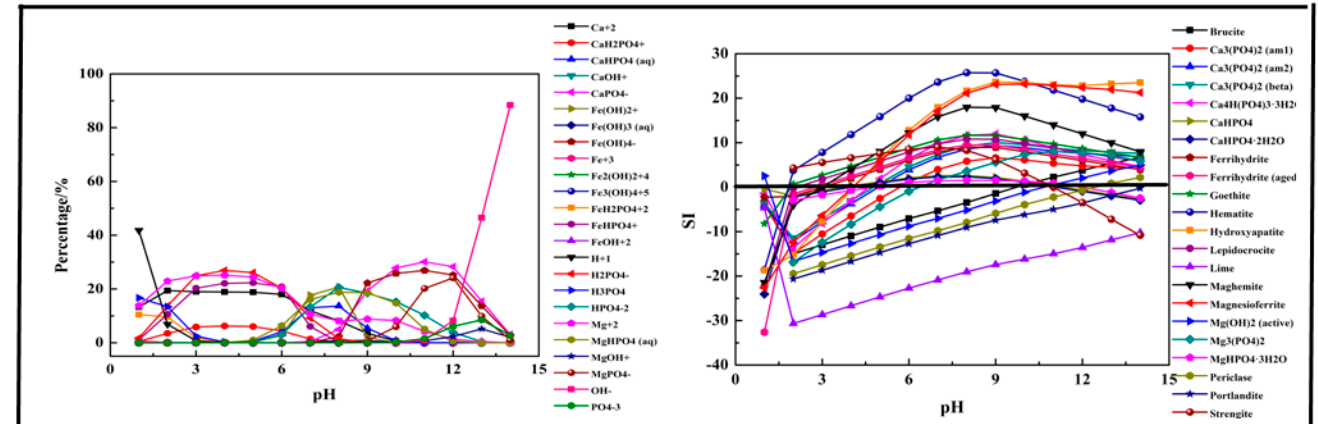
Figure 8. Percentage of species in the Fe-Ca-Mg-P-H 2 O system at 298 K at ranged pH ((P) = 0.01 mol/L, (Fe 3+ ) = 0.004 mol/L, (Ca 2+ ) = 0.0045 mol/L, (Mg 2+ ) = 0.0045 mol/L).